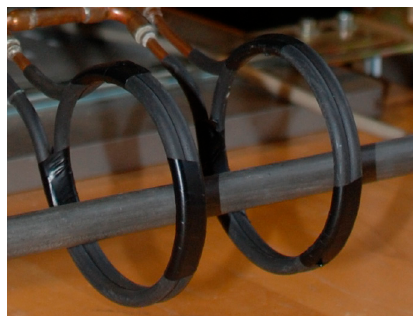
Figure 7. Helmholtz coil with a wire, for which the results are shown in Figure 8.